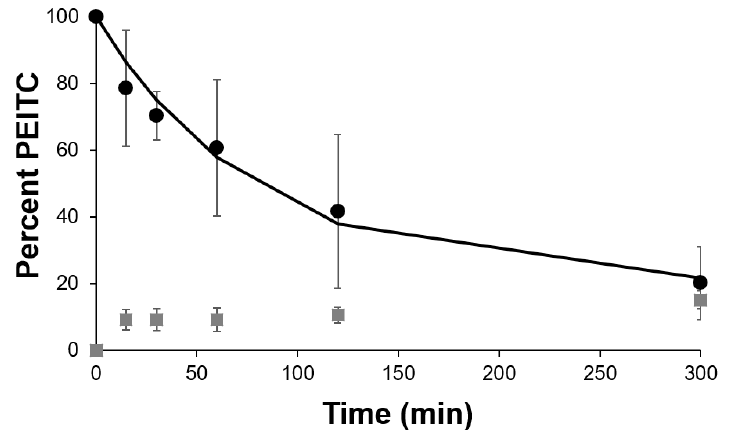
Figure 3. Percent phenethyl isothiocyanate (PEITC) in gel (black circle markers and the black line) and in receptor (gray square markers) over time, when on a STRAT-M membrane in a Franz cell at 37 °C.